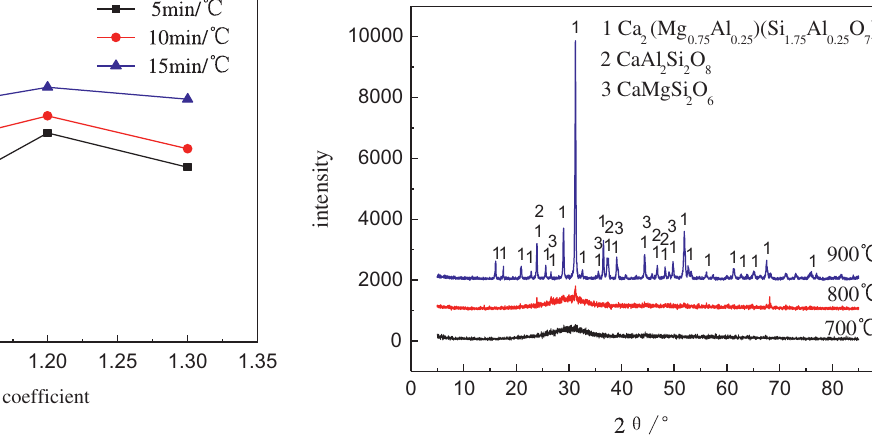
Figure 5: Effect of acidity coefficient on the glass transition temperature. Figure 7: Effect of heating-treatment on the crystallization.